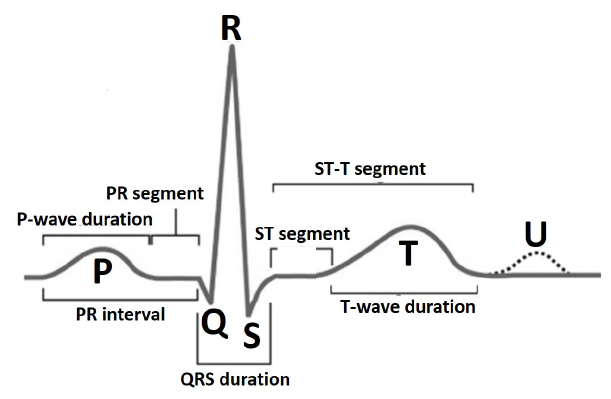
Figure 1. PQRST wave and primary fiducial markers for ECG